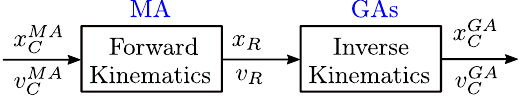
Figure 6: Guide arm at max reach ( x R = 4 [ m ] and x GA 1 . 04 [ m